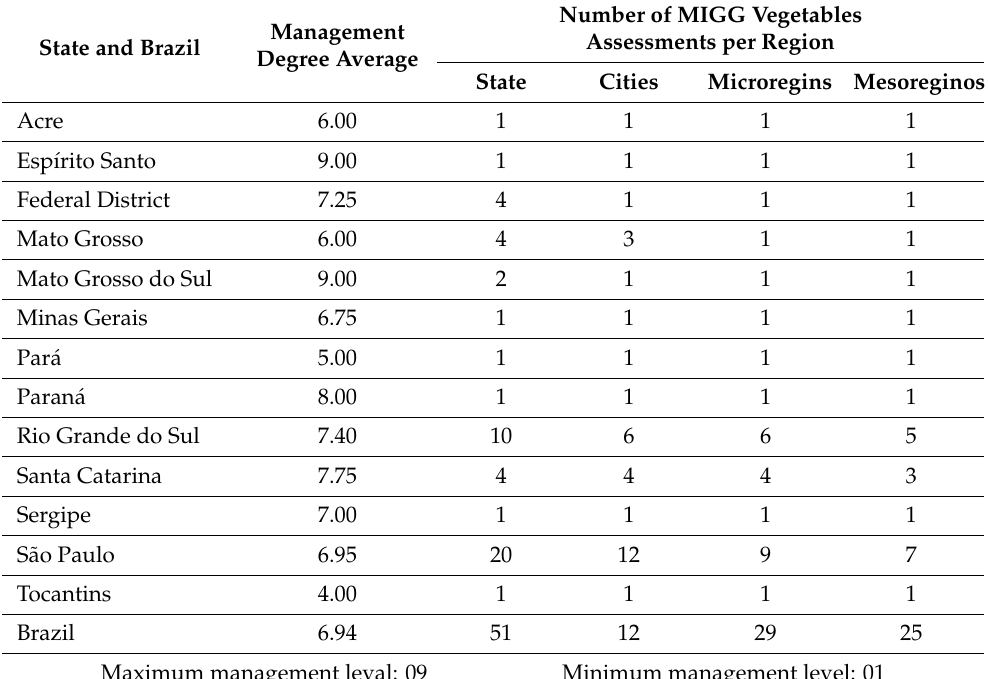
Table 5. Management degree in Brazilian Vegetables production according to MIGG